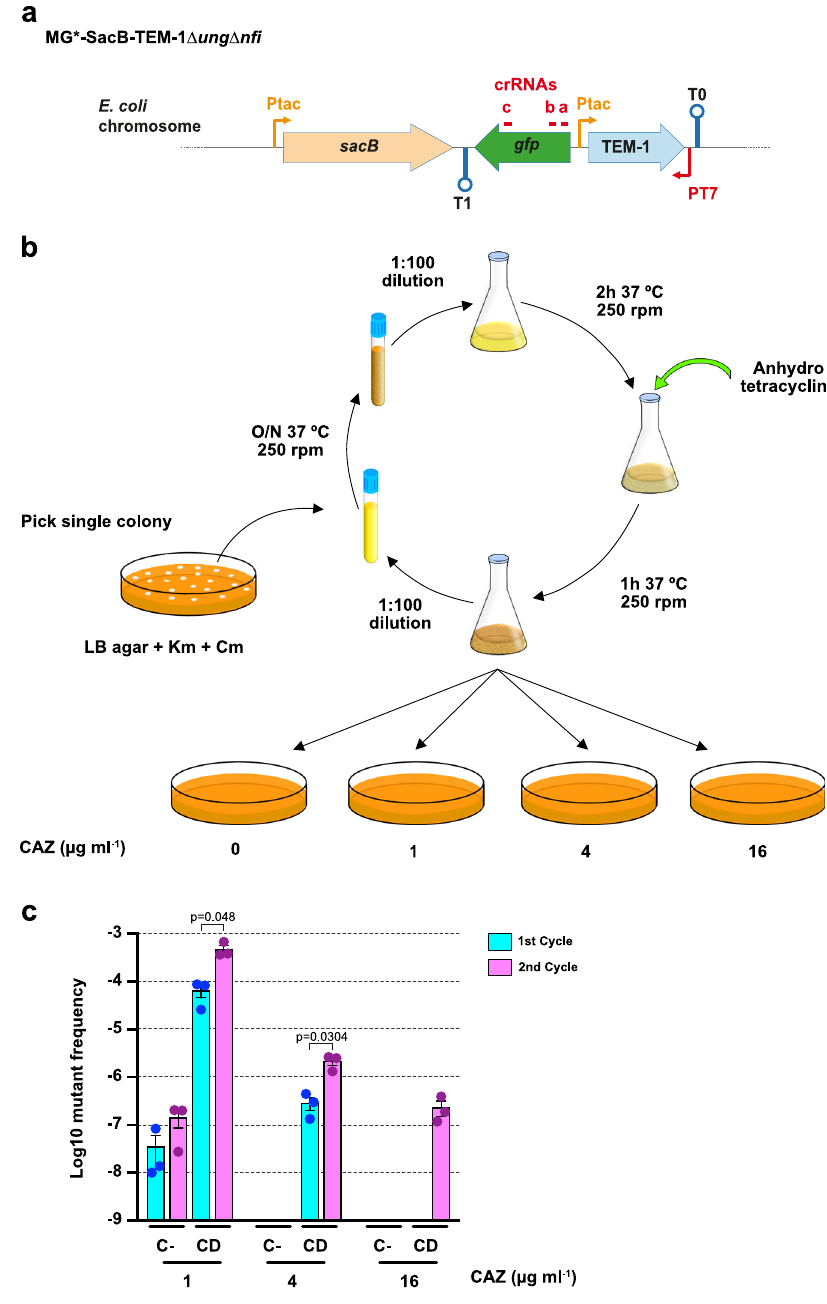
Fig. 7 TEM-1 evolution using the mutagenesis system. a Scheme of the cassette with the TEM-1 gene in the strain MG*-SacB-TEM-1 Δ ung Δ n fi . Thin arrows indicate the tac (P tac ) and T7 (P T7 ) promoters, lollipop shapes indicate terminators T0 and T1. The genes sacB , gfp , and URA3 are represented with orange, green, and yellow fi lled arrows, respectively. Red lines mark targeting sequences of the crRNAs a, b, and c. b Scheme of the continuous evolution process with iterative cycles of mutagenesis induction. Transformed colonies of MG*-SacB-TEM-1 Δ ung Δ n fi with the plasmids pdCas9b.a.c and pSEVA221AID-T7RNAP were grown overnight (O/N) in LB with Cm and Km at 37 °C with shaking (250 r.p.m.). The next day, the cultures were diluted 1:100 in fresh medium and incubated under the same conditions for 2 h. Then anhydrotetracycline (aTc; 200 ng ml − 1 ) was added for induction and the cultures were incubated for 1 h. To start the second cycle of mutagenesis, the induced cultures were diluted 1:100 in new medium and grown O/N repeting the same steps as above. To monitor the mutagenic process, after every induction the cultures were washed with 1× PBS and serially diluted prior to be plated on LB agar alone and with increasing concentrations of ceftazidime (CAZ; 1, 4, and 16 µ g ml − 1 ). The strain MG*-SacB-TEM-1 Δ ung Δ n fi with the plasmids pdCas9 and pSEVA221 was used as a control of the spontaneous mutations occurring in TEM-1 . c Resistance frequency to increasing concentrations of ceftazidime (CAZ) after each cycle of the cytosine deaminase induced cultures of MG*-SacB-TEM-1 Δ ung Δ n fi pdCas9b.a.c pSEVA221AID-T7RNAP (CD). As negative control (C − ), the strain MG*-SacB-TEM-1 Δ ung Δ n fi with the plasmids pdCas9 and pSEVA221 was used. The histogram shows the single values (color coded dots), means (bars), and standard errors (black lines) from three independent cultures for each strain ( n = 3). The statistical analysis was done using a two-tailed paired t test. Exact p values ( p ) are indicated in the fi gure. A p value < 0.05 was considered signi fi cant. Source data are provided as a Source data fi